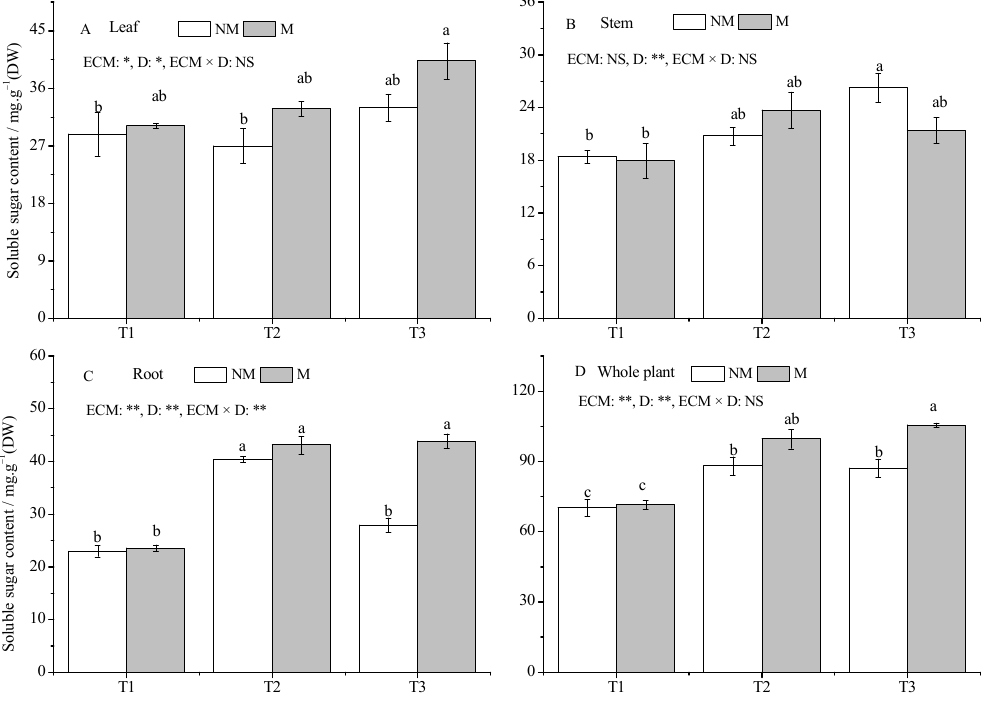
Figure 4. Effect of ECMF and drought on soluble sugar contents of various tissues and whole plants of P. massoniana. Values (means ± SEs) followed by different letters among treatments indicate significant differences at the 5% level, and the same letter indicates no significant difference. NS, not significant, * p < 0.05; ** p < 0.01. T1, well-watered, T2, moderate drought, and T3, severe drought. NM, no Sl inoculation, M, Sl inoculation. D, drought treatment. The letters denote ( A ) leaf soluble sugar; ( B ) stem soluble sugar; ( C ) root soluble sugar; ( D ) whole plant soluble sugar.